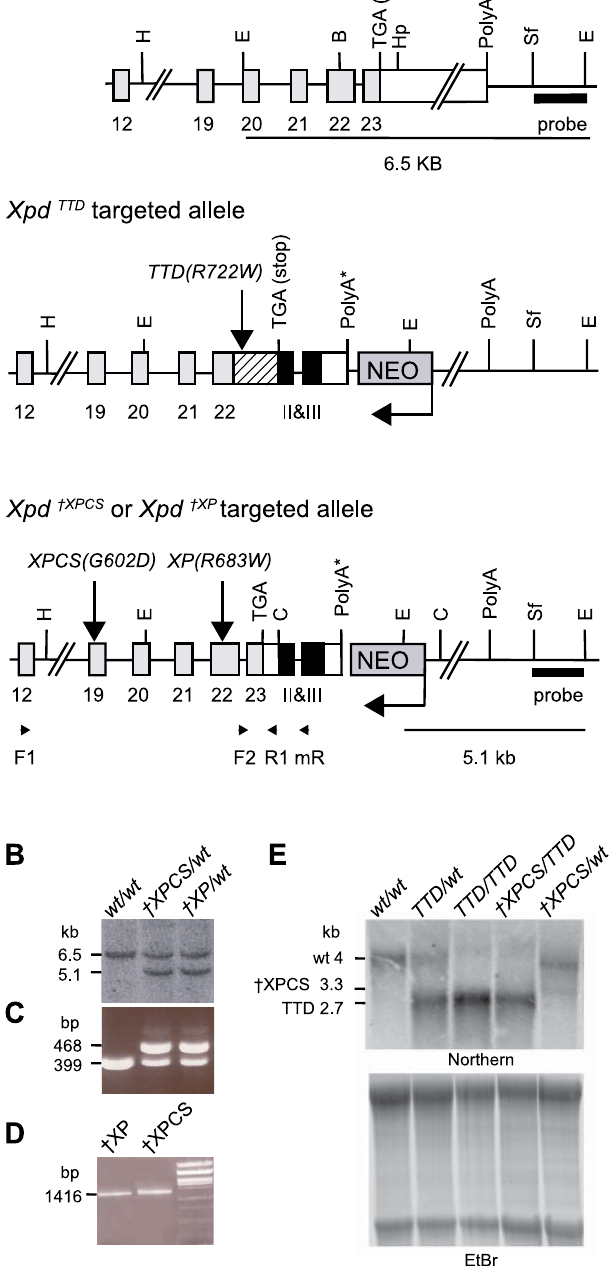
Figure 1. Targeting of the Mouse Xpd Gene (A) Schematic representation of the genomic structure and partial restriction map of the wt and targeted mouse Xpd loci. For the wt Xpd allele, shaded boxes represent coding regions of exons 12 and 19–23; the 3 9 UTR is represented by an open box. TGA indicates the translational stop codon; PolyA indicates the polyadenylation signal. For the Xpd TTD targeted allele, the 194–base pair (bp) human XPD cDNA fragment fused to exon 22 is indicated as a striped box including the TTD (R722W) mutation indicated by a vertical arrow. Chicken b -globin exons 2 and 3 including the 3 9 UTR are indicated as black boxes with corresponding Roman numerals followed by the b -globin polyadenylation signal (PolyA*). For the Xpd (cid:1) XP and Xpd (cid:1) XPCS targeted alleles, vertical arrows indicate XPCS (G602D-encoding) and XP (R683W-encoding) mutations in exons 19 and 22, respectively. The unique 3 9 probe located outside